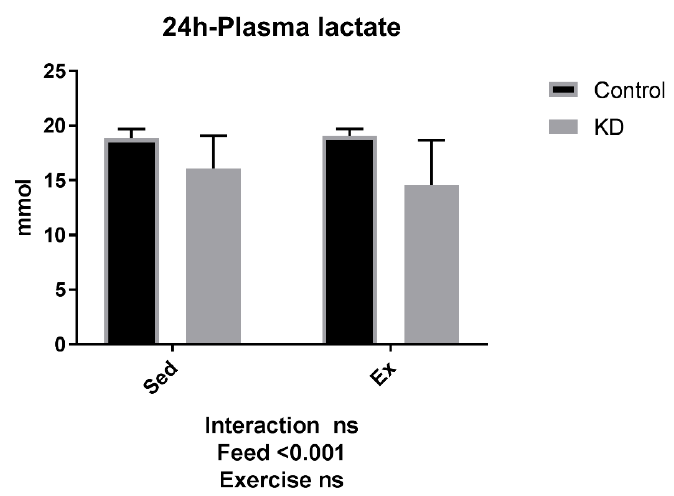
Figure 3. Muscle and plasma lactate concentration of mice 24 h after exhaustion.